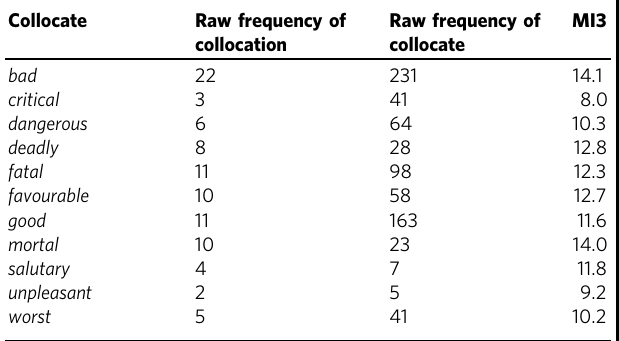
Table 9 Adjective collocates of keyword SYMPTOM, raw frequency = 348.